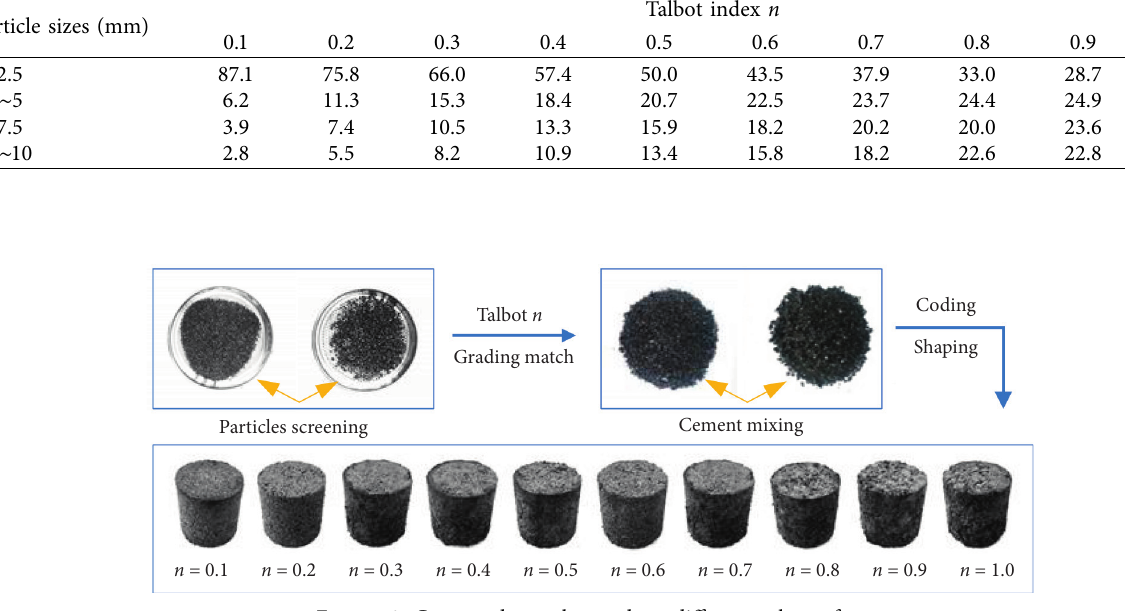
Figure 2: Cemented samples made at different values of n